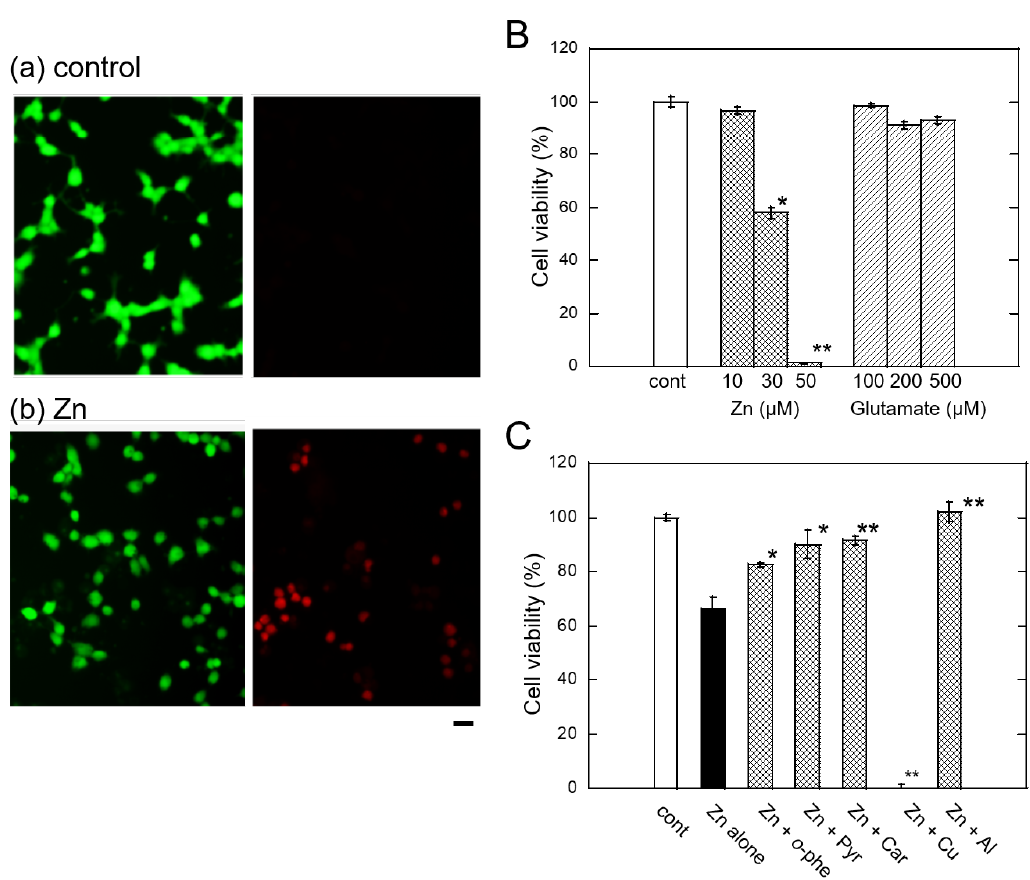
Figure 1. Zn 2 + -induced neurotoxicity in GT1–7 cells. ( A ) GT1–7 cells were exposed to with or without 30 µ M ZnCl 2 . After 24 h, live cells were stained with carboxy fluorescein (green) and dead cells were stained with propidium iodide (red). Bar represents 50 µ M. ( B ) Viability of GT1–7 cells after exposure to Zn or glutamate. GT1–7 cells were treated with ZnCl 2 , or glutamate. After 24 h, cell viability was analyzed using the WST-1 method, which counts the living cell number by measures the cellular mitochondrial dehydrogenase activity [52]. Data are expressed as mean ± SEM, n = 6. * p < 0.05, ** p < 0.01, compared with control. ( C ) Viability of GT1–7 cells after exposure to Zn with other pharmacological substances. GT1–7 cells were treated with 30 µ M Zn with sodium pyruvate (Pyr: 1 mM), o -phenanthroline ( o -phe; 20 µ M) carnosine (Car: 1 mM), CuCl 2 (10 µ M), or AlCl 3 (100 µ M). After 24 h, cell viability was analyzed using the WST-1 method. Data are expressed as mean ± SEM, n = 6. * p < 0.05, ** p < 0.01 compared with Zn alone.